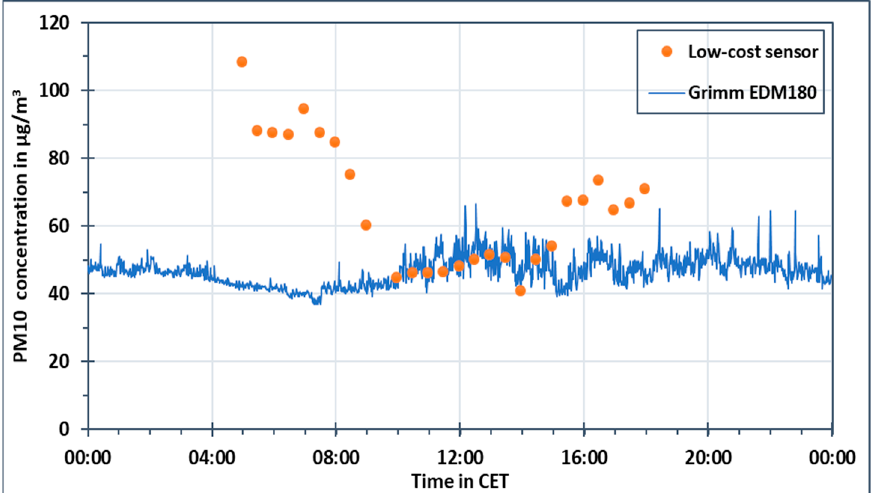
Figure 10. PM10 concentration measured using the sensor-monitoring box and aerosol spectrometer Grimm EDM180 on 21 February 2019.